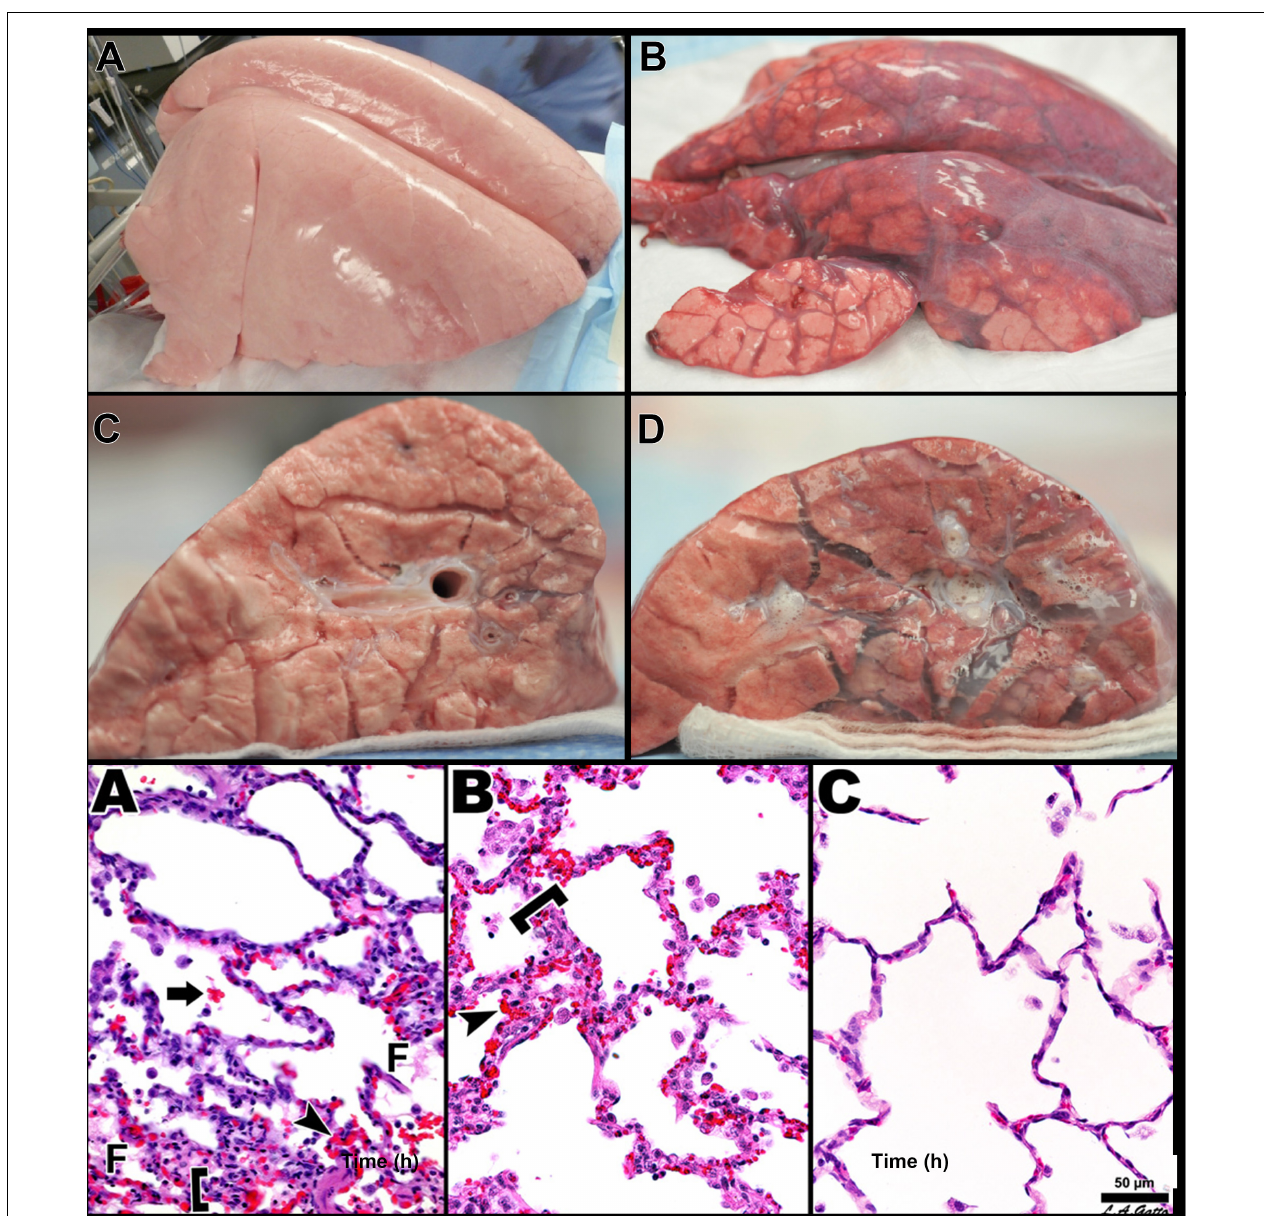
FIGURE 11 | Three groups of pigs were ventilated for 48 h with a clinically applicable, high-fidelity porcine peritoneal sepsis (PS) and gut ischemia/reperfusion (I/R) acute respiratory distress syndrome (ARDS) model: (1) Control group without PS + I/R injury ventilated with a tidal volume (Vt) of 10 cc/kg and a positive end-expiratory pressure (PEEP) of 5 cm H 2 O. (2) ARDSnet group using a low-Vt ventilation method, applied following PS + I/R injury at the time point at which the animal reached the oxygen saturation limit listed in the ARDSnet protocol, with PEEP and FiO 2 adjusted by oxygenation (Acute Respiratory Distress Syndrome Network, 2000). (3) Time-controlled adaptive ventilation ( TCAV ) method using the airway pressure release ventilation (APRV) mode applied immediately after PS + I/R injury (Habashi, 2005; Jain et al., 2016). Upper – Gross lung photographs after 48 h of ventilation following PS + I/R injury at necropsy ( Control not shown). In the TCAV group (A,B) , lungs inflated fully to near total lung capacity at 25 cm H 2 O without any gross atelectasis. The cut surface of the diaphragmatic lobe also showed no interstitial or airway edema and no atelectasis. Lungs in the ARDSnet group (C,D) also inflated to 25 cm H 2 O showed low lung volume with heterogeneous collapse and atelectasis and were wet and “boggy.” The cut surface showed both interstitial and airway edema. Lower – Photomicrographs of representative lung sections of specimens from the Control (A) , ARDSnet (B) , and TCAV (C) groups each at 40 × magnification. F, fibrinous deposit in the air compartment; arrow, blood in alveolus; arrowhead, congested alveolar capillary; bracket, thickened alveolar wall. (A) Control : animals received 48 h of mechanical ventilation without PS + I/R injury. Specimen shows typical early acute lung injury pathology including fibrinous deposits, blood in alveolus, congested capillaries, and thickened alveolar walls. (B) ARDSnet : animals received PS + I/R injury, and LVt ventilation was applied after the onset of acute lung injury (i.e., PaO 2 /FiO 2 ratio < 300). Specimen shows typical advanced acute lung injury pathology including fibrinous deposits, blood in alveolus, congested capillaries, leukocyte infiltration, and thickened alveolar walls. (C) TCAV : specimen shows normal pulmonary architecture, alveoli are well-expanded and thin walled, and there are no exudates (Roy S. et al., 2013). Permissions obtained from Wolters Kluwer Health, Inc. License 4699411460832.